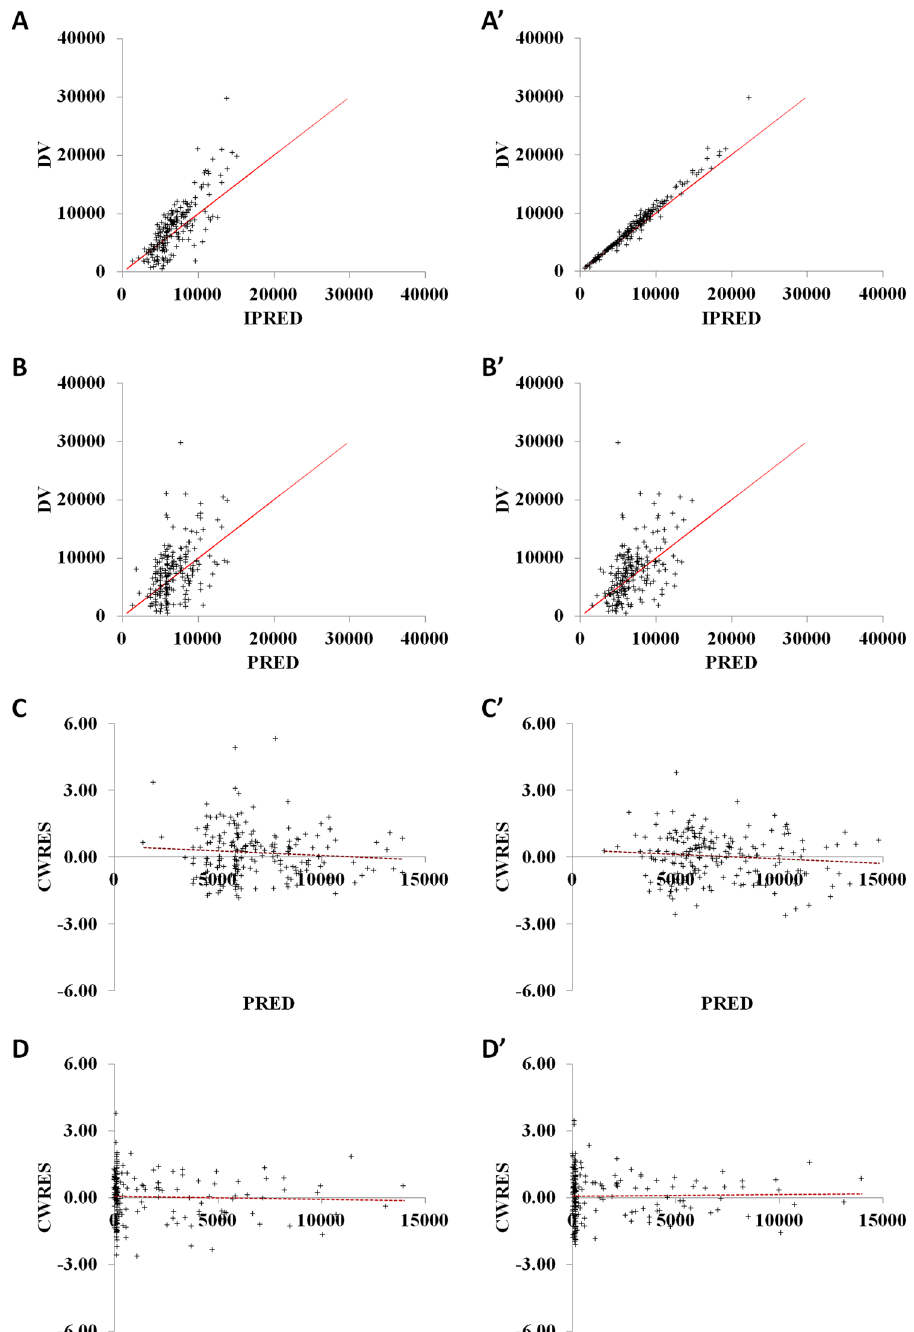
Figure 3. Goodness-of-fit of basic ( A,B,C and D ) and final ( A’,B’,C’ and D’ ) models. DV: dependent variable (observation); IPRED: individual prediction; PRED: prediction; CWRES: conditional weighted residuals. Solid lines represent identity lines and dashed lines mean zero lines. ( A and A’ ): observation versus individual predictions; ( B and B’ ): observation versus predictions; ( C and C’ ): conditional weighted residuals versus predictions; ( D and D’ ): conditional weighted residuals versus